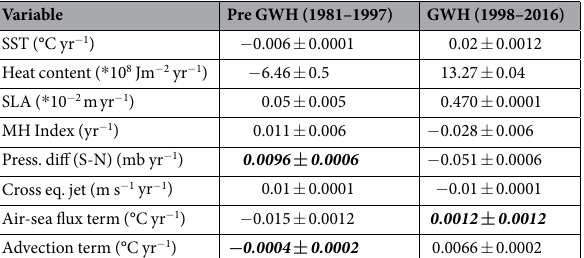
− MHslp MHslp = MH intensity Standard Deviation (4)